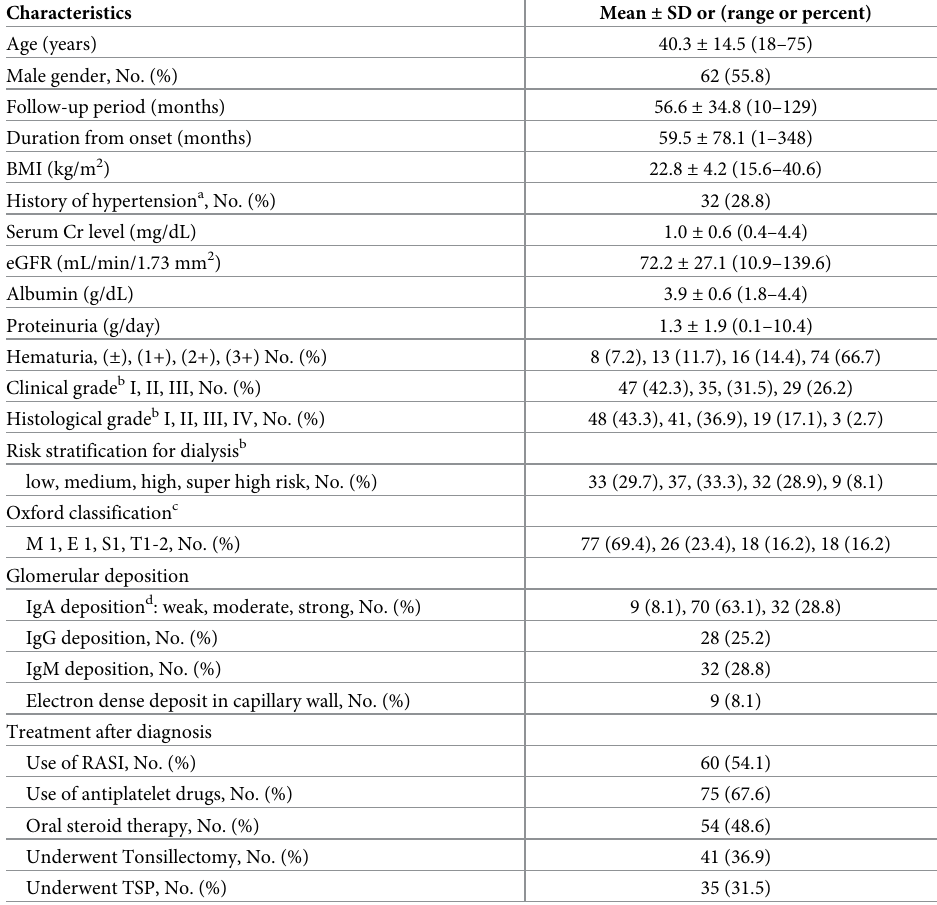
Table 1. Baseline characteristics and therapeutic regimens of 111 patients with IgAN.